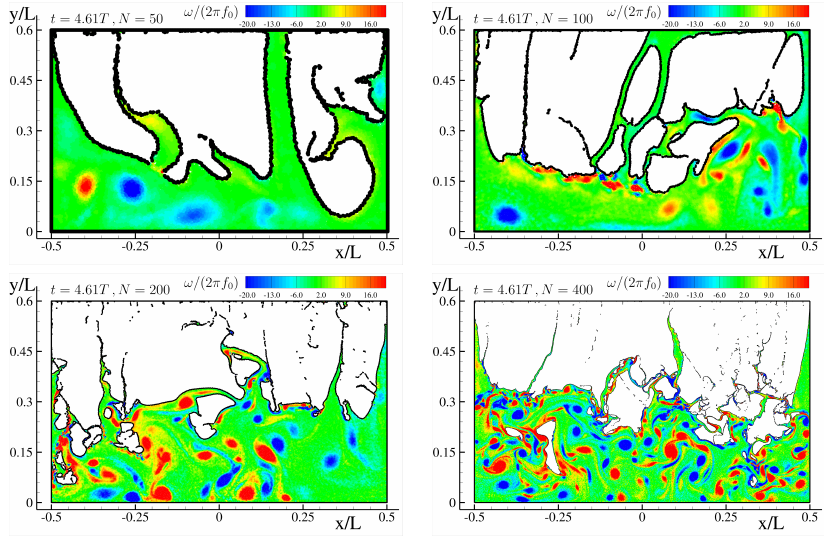
Figure 5. Test with water: vorticity fields at the fourth bottom impact for different spatial resolutions N = 50, 100, 200, 400.